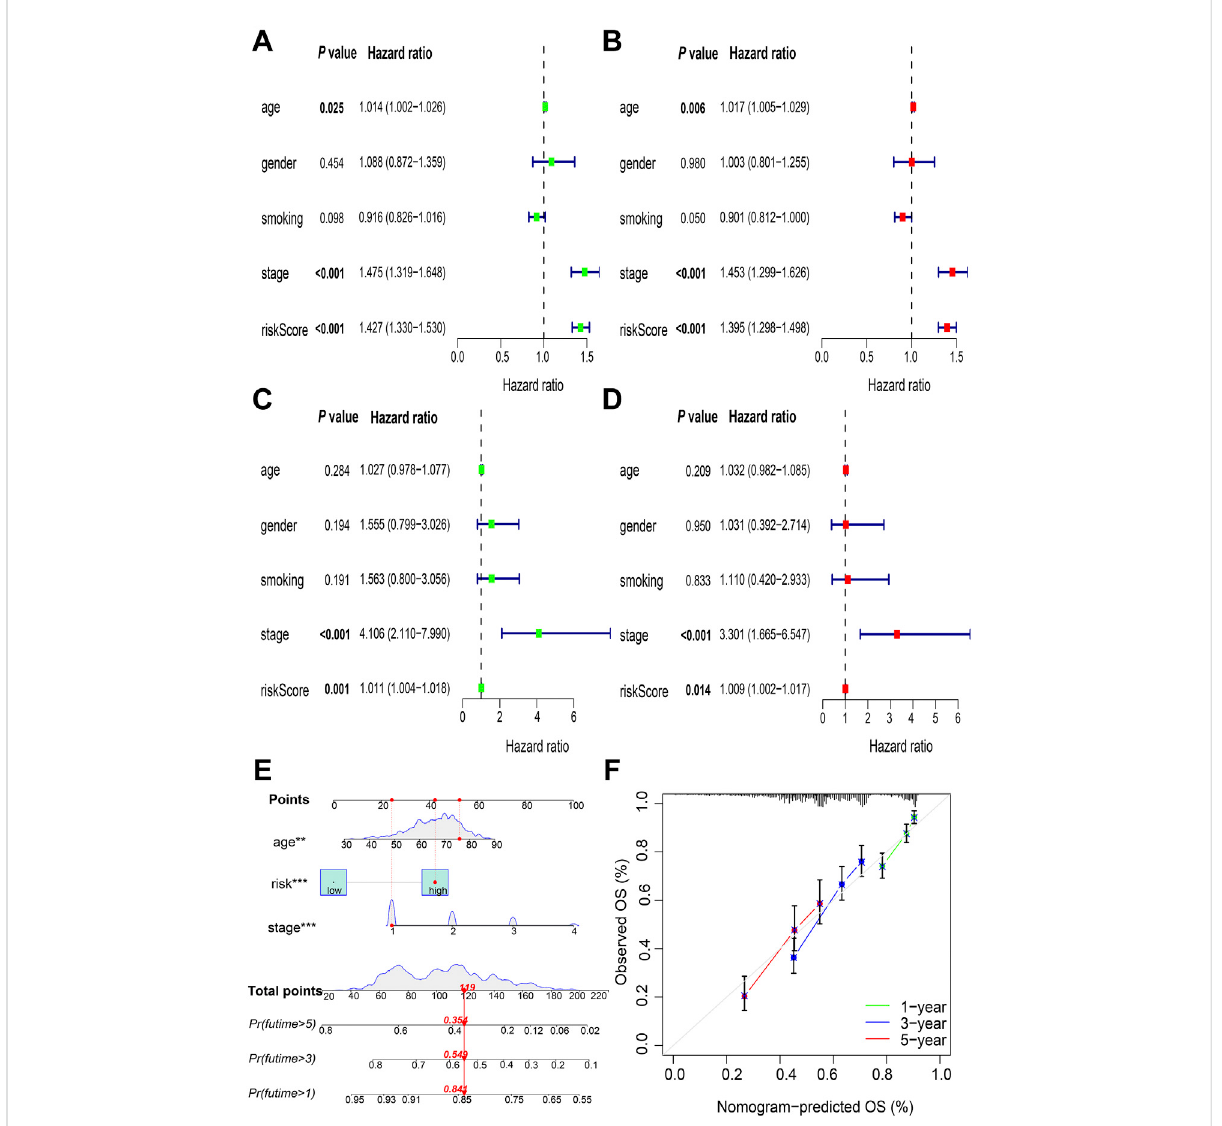
FIGURE 5 Identi fi cation of independent prognostic factors and construction of nomogram. Validation of the risk score as an independent prognostic factor using the univariate Cox analysis in (A) TCGA cohorts and (C) GSE31210 cohorts, and multivariate Cox analysis in (B) TCGA cohorts and (D) GSE31210 cohorts (E) Nomogram to predict OS at the end of 1-, 3-, and 5-year periods (F) Calibration plots of the nomogram. TCGA, The Cancer Genome Atlas; OS, overall survival. ** p < 0.01; *** p <